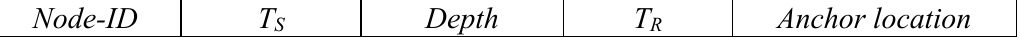
Figure 4. Localization applicant message format.